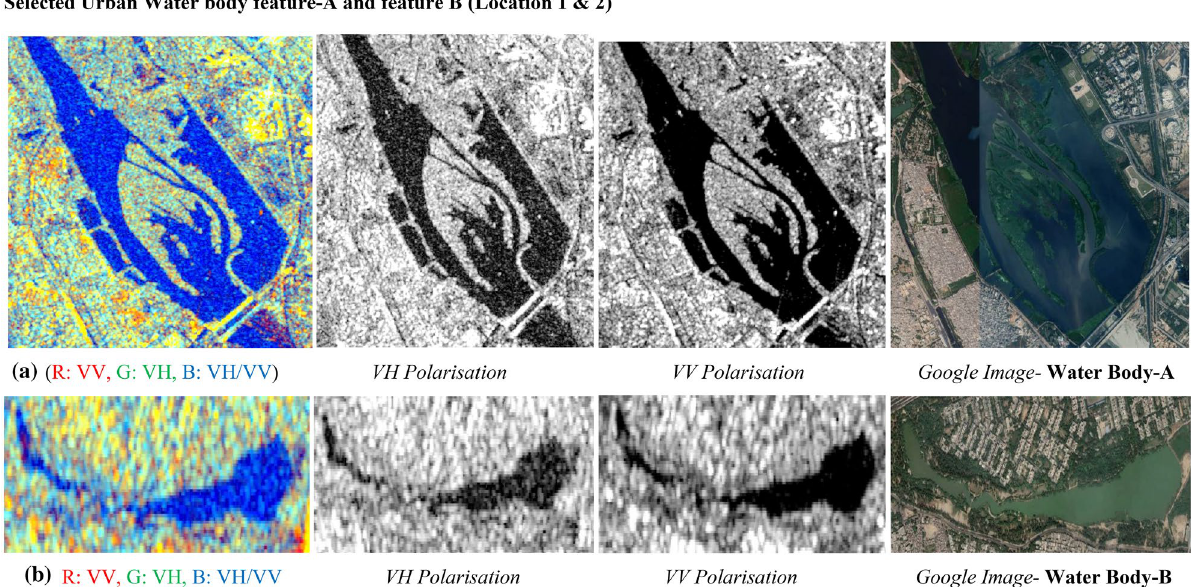
Figure 24. Colour composite image of the Sentinel-1 C-band data, dual-polarization data, and Google Image for site A &